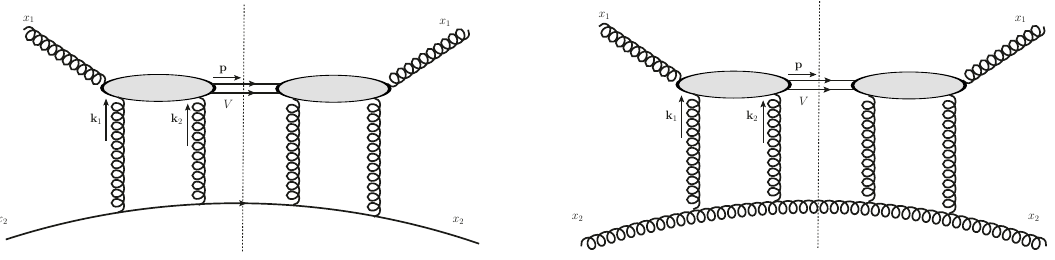
Figure 4 . The lowest order diagrams for the amplitude squared for the production of the heavy vector meson through the coupling of 1 + 2 gluons o(cid:11) a quark (left) and o(cid:11) a gluon